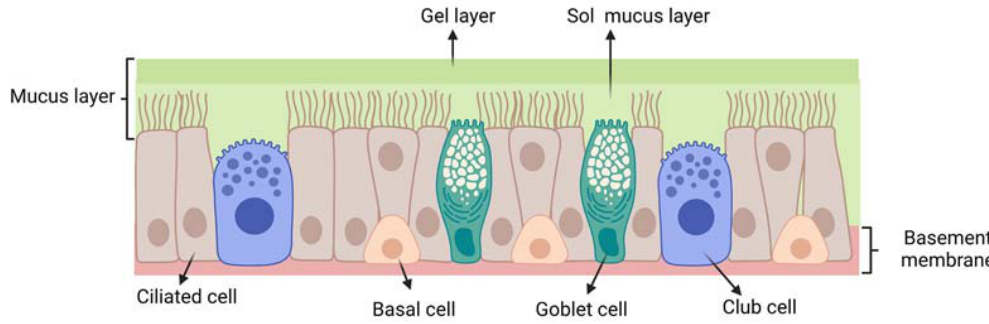
Figure 4. Schematic representation of the respiratory epithelium: ciliated pseudostratified columnar epithelial cells; club cells (non ‐ ciliated cells); goblet cells; mucus layer (gel layer); sol mucus layer; basal cells; basement membrane. Created with BioRender.com.